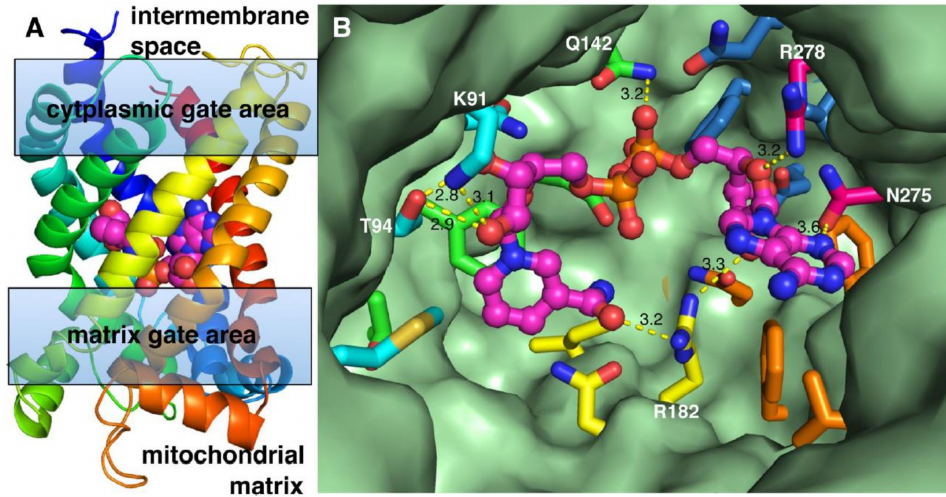
Figure 3. Docking of NAD + into the structural homology model of SLC25A51. A structural homology model of SLC25A51 was generated based on the bovine and yeast ADP/ATP carrier structures (PDB ID: 1OKC, 4C9Q, and 4C9G) by Modeller [68]. Conformationally flexible NAD + was docked into the active site of the SLC25A51 structural model with flexible side chains by Autodock Vina [69]. ( A ) The highest-ranked docking solution (binding energy = − 9.9 kcal/mol; interface area = 532 Å 2 ) is displayed with the protein in cartoon with rainbow colours from N-terminus (blue) to C-terminus (red) and NAD + in spheres (carbons in magenta) viewed from the mitochondrial inner membrane plane. ( B ) The residues of the substrate binding site of the same docking solution are viewed from the intermembrane space side: NAD + and the residues interacting with it are shown in ball-and-stick and sticks, respectively, with carbons in the same colour as in ( A